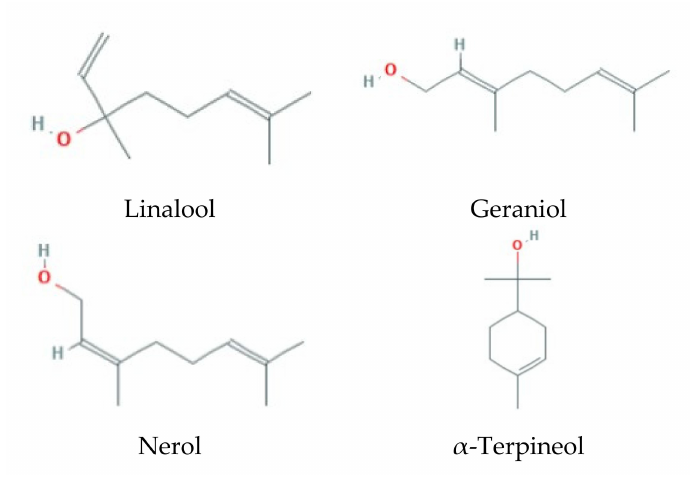
Figure 1. Chemical structures of the major aroma compounds in Muscat grape